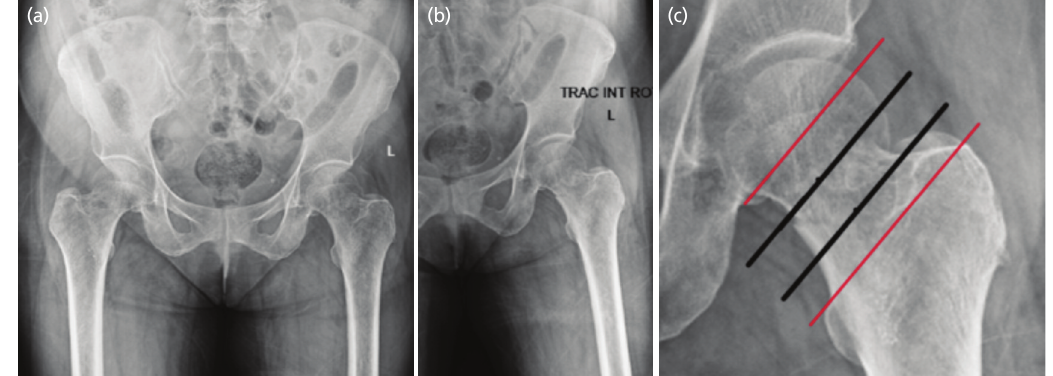
(a, b, c) Radiographs depicting 66-year-old female with Singh index grading 4 who sustained a transcervical Fig. 6: